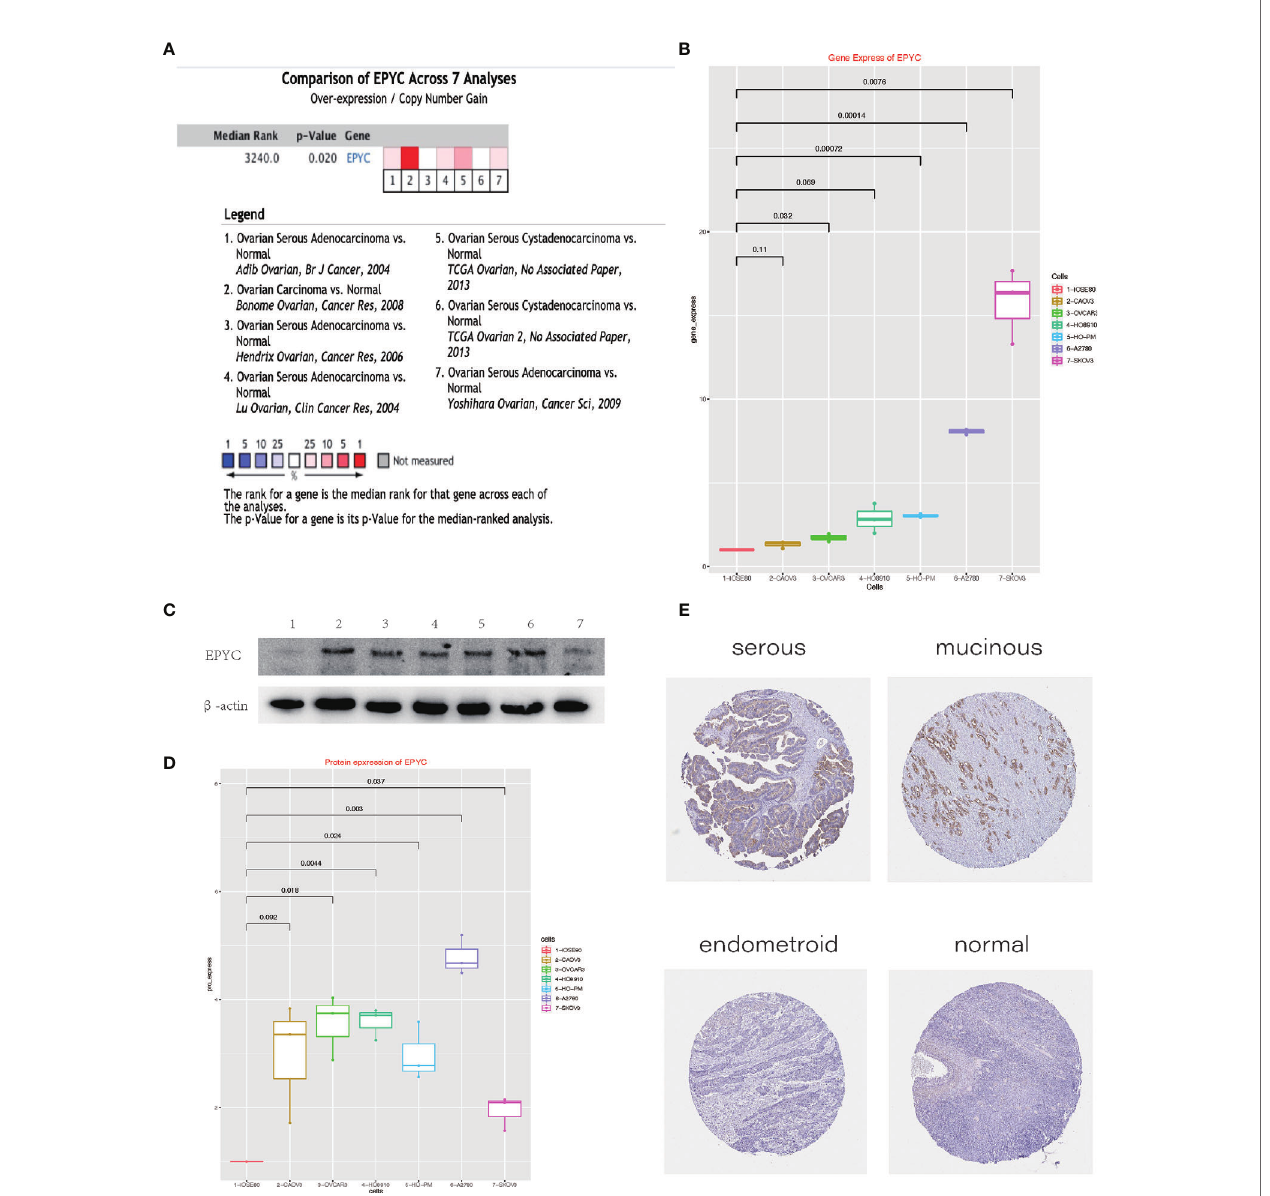
FIGURE 2 | The expression of EPYC in ovarian cancer is signi fi cantly increased. (A) Oncomine website meta-analysis of EPYC expression in normal ovarian tissues and ovarian cancer tissues. (B) Real-time PCR to detect the expression of EPYC in ovarian cancer cells and normal ovarian cells. (C, D) Western-blot detects the expression of EPYC in ovarian cancer cells and normal ovarian cells. (E) Expression of EPYC protein in normal ovary and different subtypes of OCs (Image source: The HPA website, antibody: